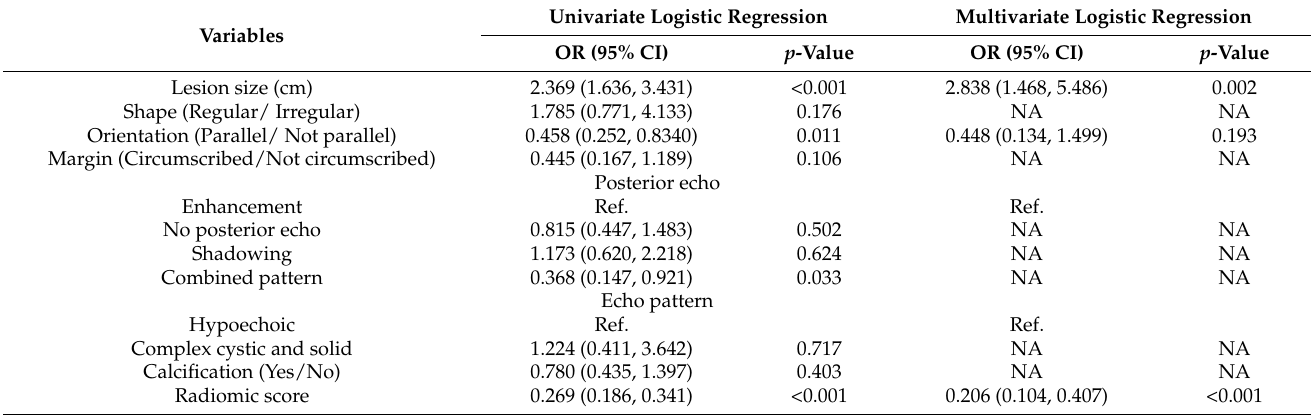
Figure 4. Receiver operating characteristic curves (ROC), calibration curves and decision curve anal- ysis of the ABVS radiomic nomogram in training and validation cohort. ( A ) In the training and validation cohort, the AUC of the radiomic nomogram (red lines) were 0.959 and 0.925, and the AUC of the radiomic score (blue line) were 0.875 and 0.897, respectively. ( B ) The calibration curves of the nomogram were close to the standard curves in the training and validation cohort, which suggested that the nomogram was well-calibrated. ( C ) Decision curve showed that when the thresh- old probability was more than 5% in the training cohort and 2% in the validation cohort, using the nomogram had more benefit than either assuming all BI-RADS 4 lesions were malignant or assum- ing all lesions were benign. 3.4. Clinical Value of The ABVS Radiomic Nomogram The decision curve analysis was used to assess the clinical significance of ABVS radi- omic nomogram (Figure 4c). Results showed that when the threshold probability was